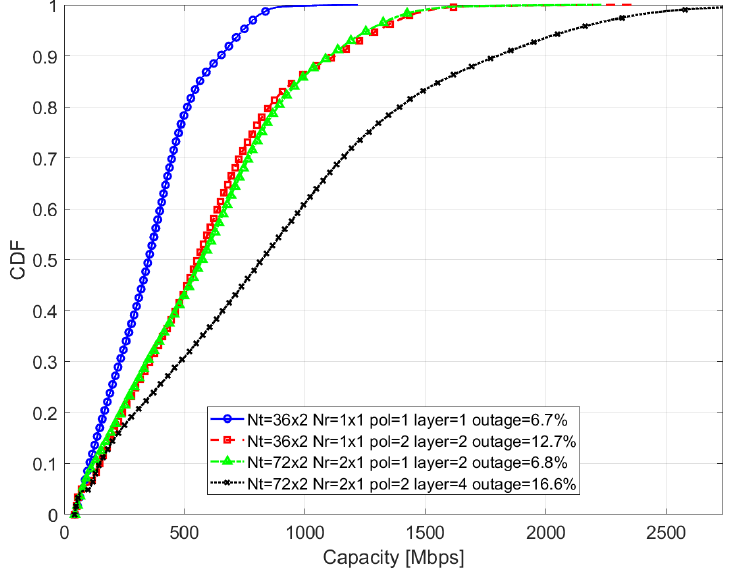
Figure 12. CDF of UT rates for different layers with single or dual polarized antenna elements, N t = [ N ty × N tz ] , N r = [ N ry × N rz ] , P TX = 47 dBm, traffic density = 2500 users/km 2